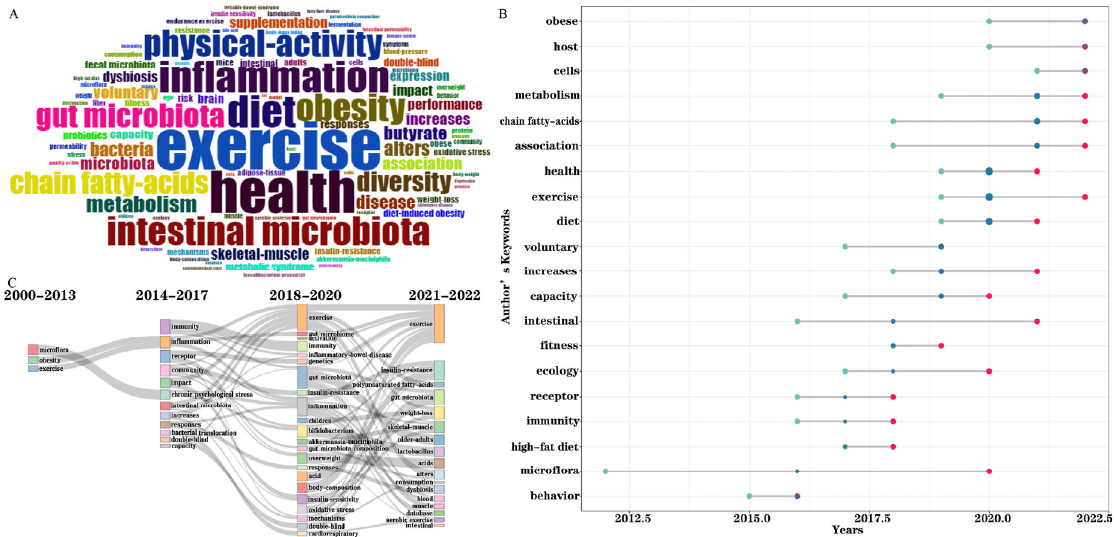
Figure 6. ( A ) Cloud graph of high–frequency keywords in the field of microbiome and exercise. ( B ) Trend topic analysis of keywords. ( C ) Evolution of research topics in the field of the microbiome and exercise.